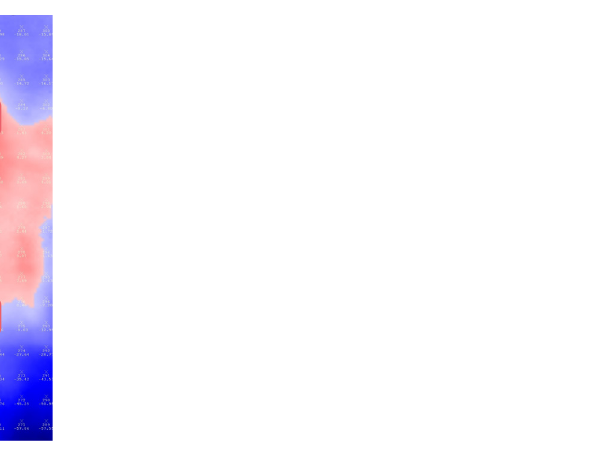
Figure 17. Relative deflection of slab from ‘Floor Inspection’ function of the ‘Real Works’ program (Post-processing step).